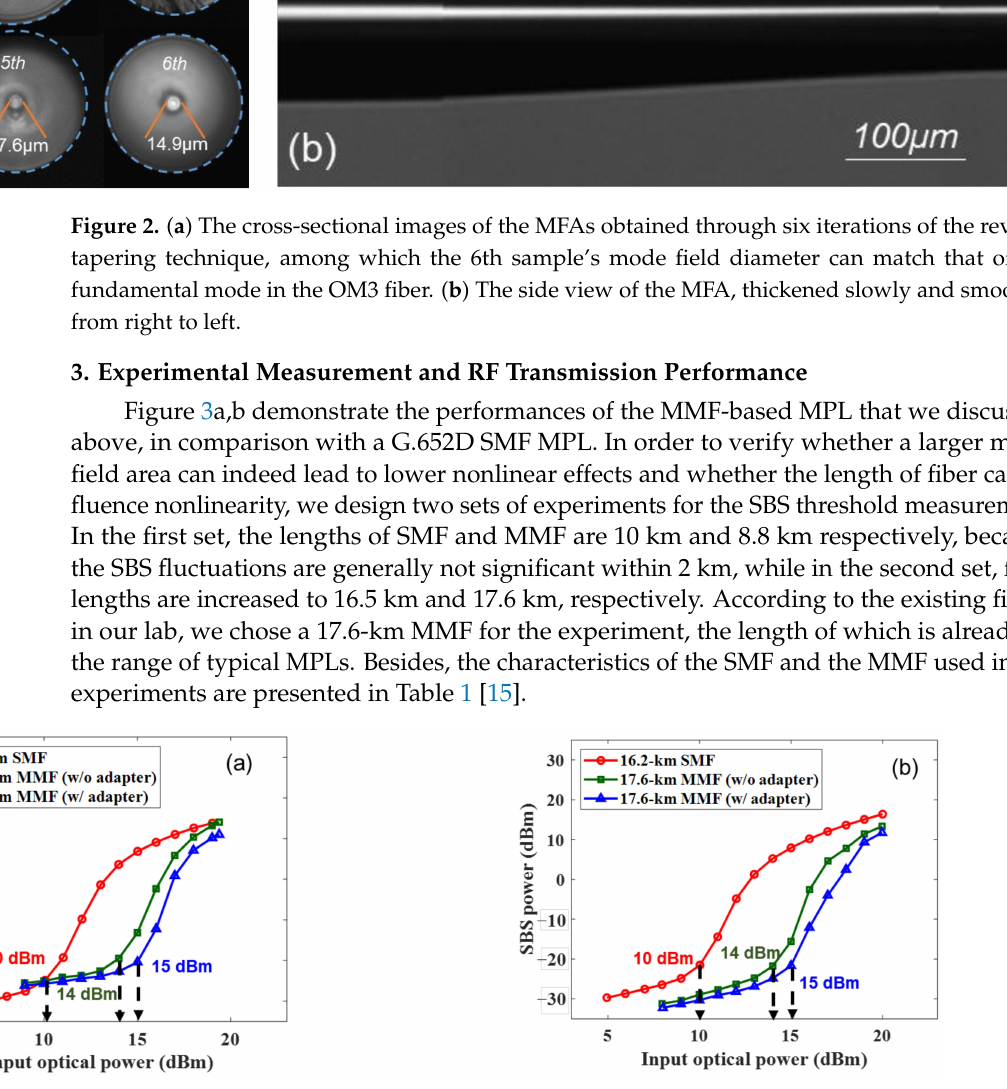
Figure 2a. The side view of the MFA obtained after the 6-th reverse tapering, which is the best match, is presented in Figure 2b. The fiber was thickened slowly from right to left. Two MFAs were fused to the two ends of the MMF, and the losses of them are 0.34 dB and 1.68 dB, respectively.